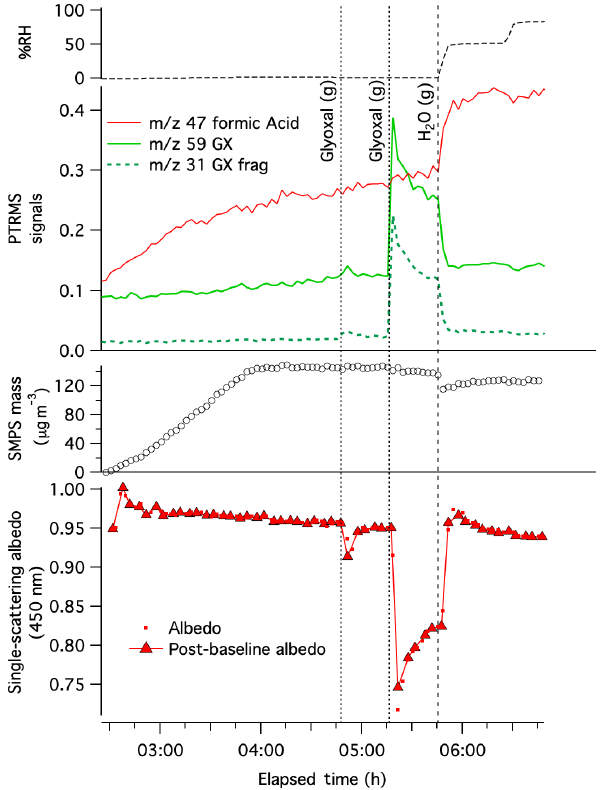
Figure 1. Pulse glyoxal addition Experiment 1 on dry AS aerosol in CESAM chamber. Top: chamber RH. Middle panels: dilution- and water-corrected PTR-MS traces for gas-phase glyoxal ( m/z = 59, green line), a glyoxal fragment ( m/z 31, dotted dark green line), formic acid ( m/z 47, red line); SMPS particulate mass corrected for wall losses and dilution (assuming aerosol density = 1 . 77gcm − 3 , open black circles), with increasing mass for the first 90min indi- cating AS aerosol addition to chamber. Bottom: single-scattering albedo (red dots) and albedo values calculated from data immedi- ately following instrument baseline on gas-phase contents of cham- ber (red triangles), measured by CAPS-ssa spectrometry at 450nm. Sequential gas “( g )” additions of 0.05 and 0.50ppm glyoxal (verti- cal dotted line) and water vapor addition (dashed lines) are labeled. Elapsed time is measured from the start of N 2 addition to the evac- uated